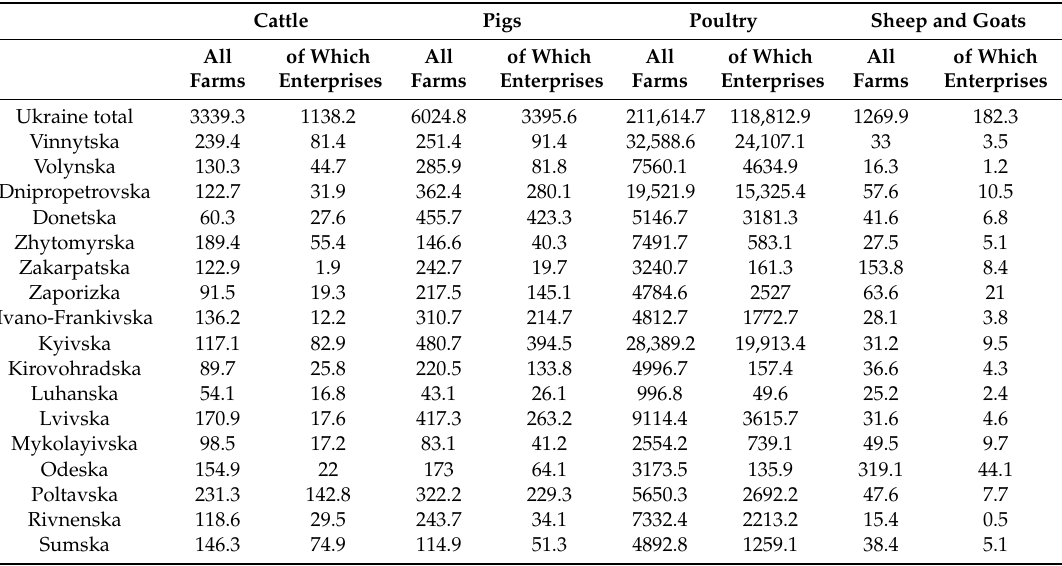
Table 2. Farm animal stocks in Ukraine (2018) in thousand